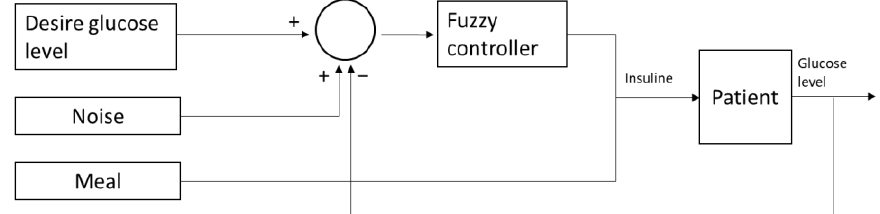
Figure 3. Diagram for the insulin control.